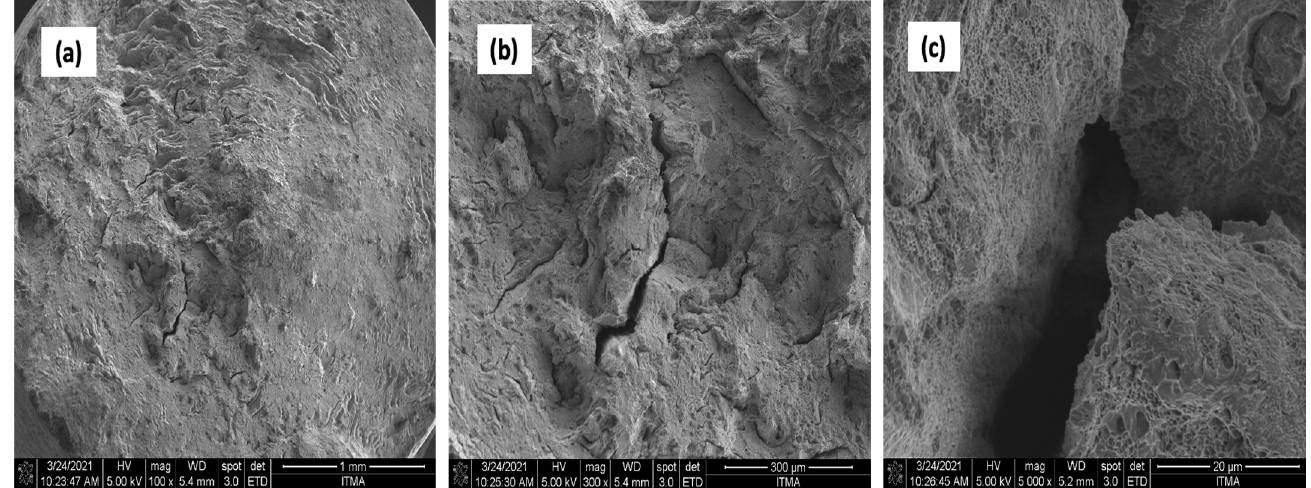
Figure 18. AA7075 1% vol ZrO 2 ( a ) 100× ( b ) 300× ( c ) 5000×.